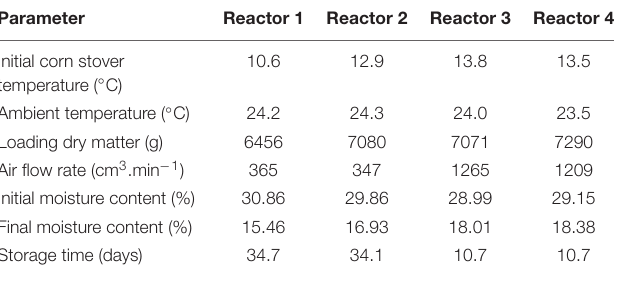
TABLE 1 | Model inputs for dynamical